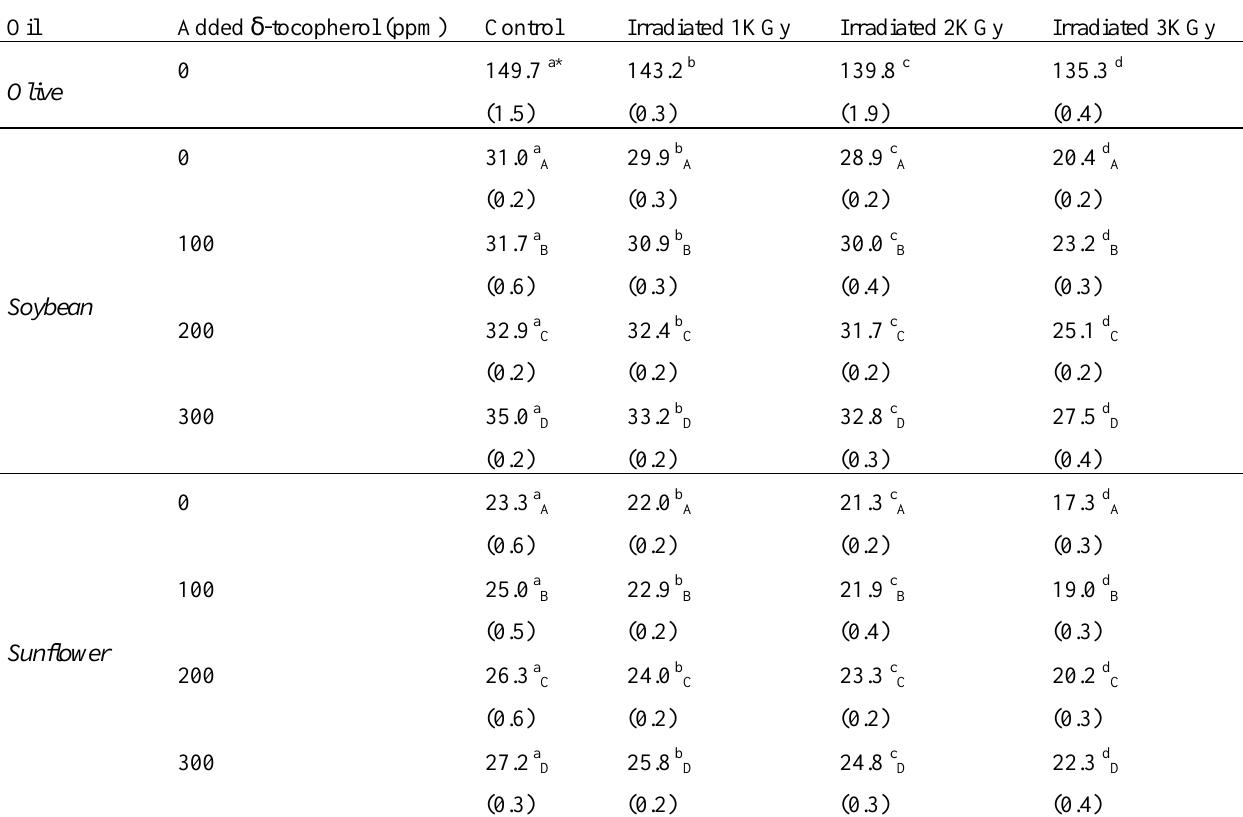
Table 1. Induction period (90 o C and 15 L/h) of vegetable oils with and without irradiation. Oil Added d -tocopherol (ppm)